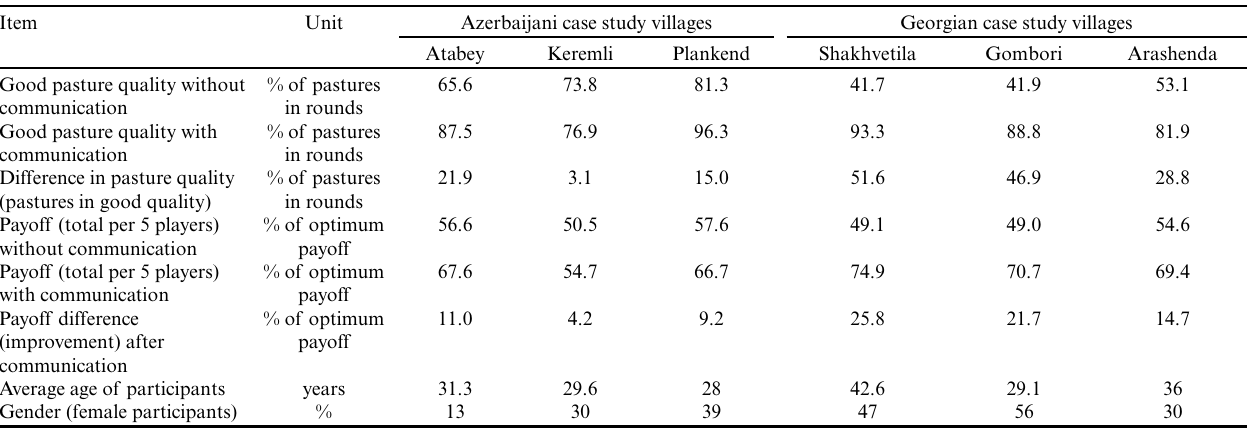
Table 5 . Game behavior of villagers in framed field